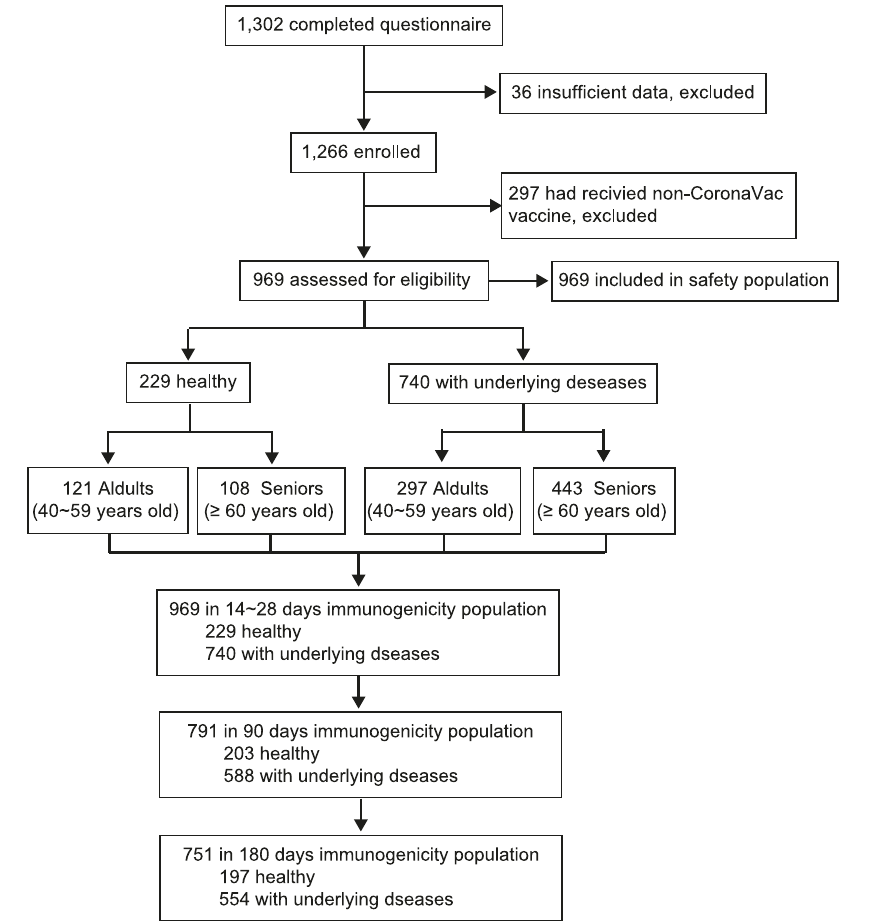
Fig. 1 Study fl ow diagram. Flow chart of recruitment and enrollment (including inclusion/exclusion criteria) for the clinical trial ChiCTR2200058281 to evaluate the immunogenicity and safety of the CoronaVac SARS-CoV-2 vaccine in people with underlying medical